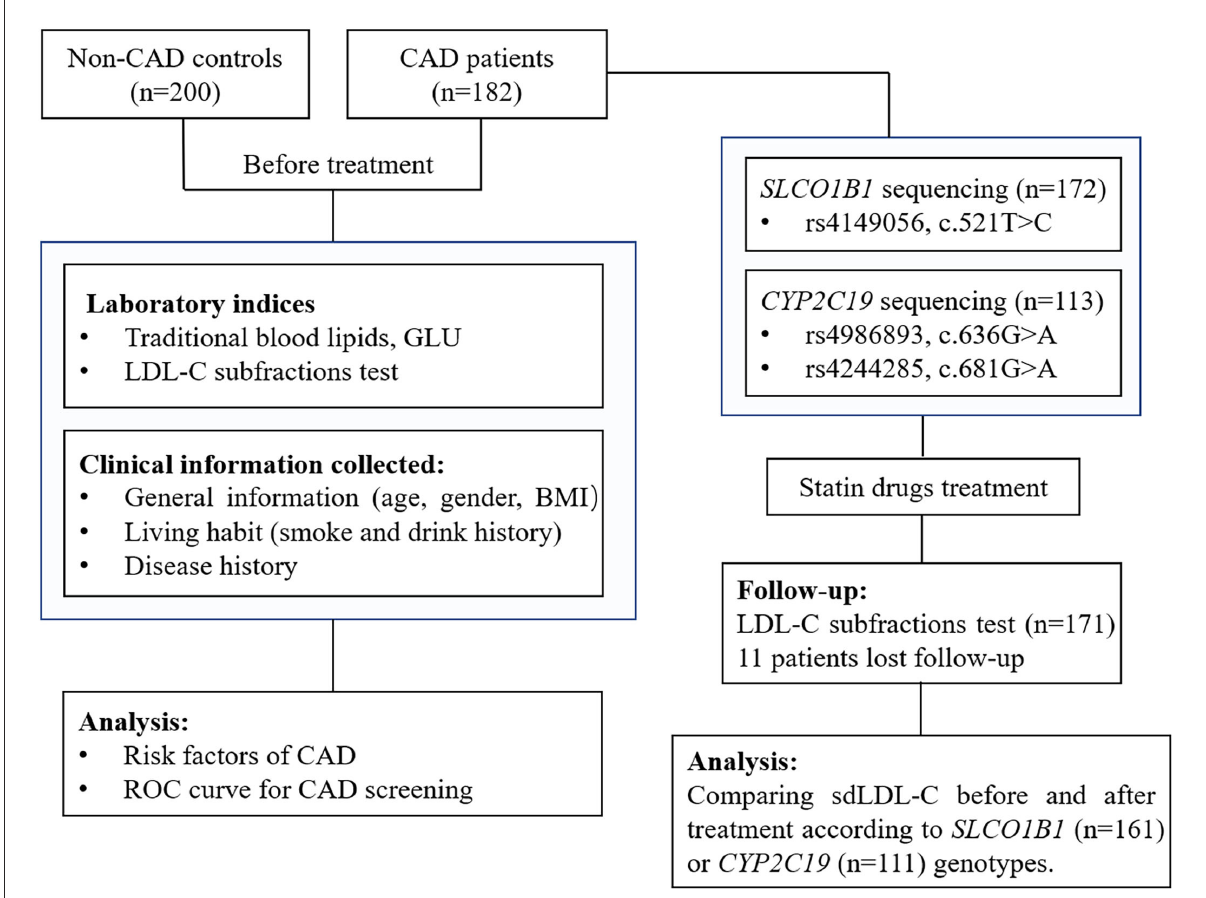
FIGURE1 A flow diagram of this study. CAD, coronary artery disease; GLU, glucose; LDL-C, low-density lipoprotein cholesterol; BMI, body mass index; ROC curve, receiver operator characteristic curve.